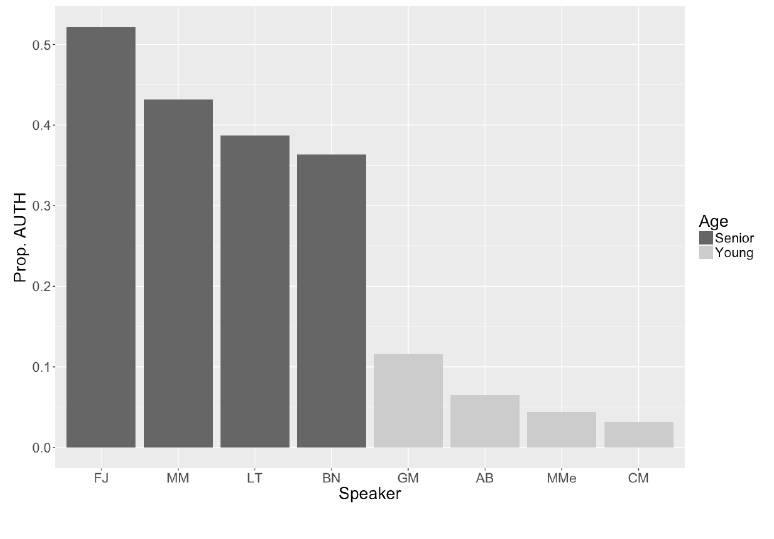
Figure 1. Proportion of auth used by senior (dark) and young (light) speakers in an identical video-elicitation task (senior speakers N=97, young speakers